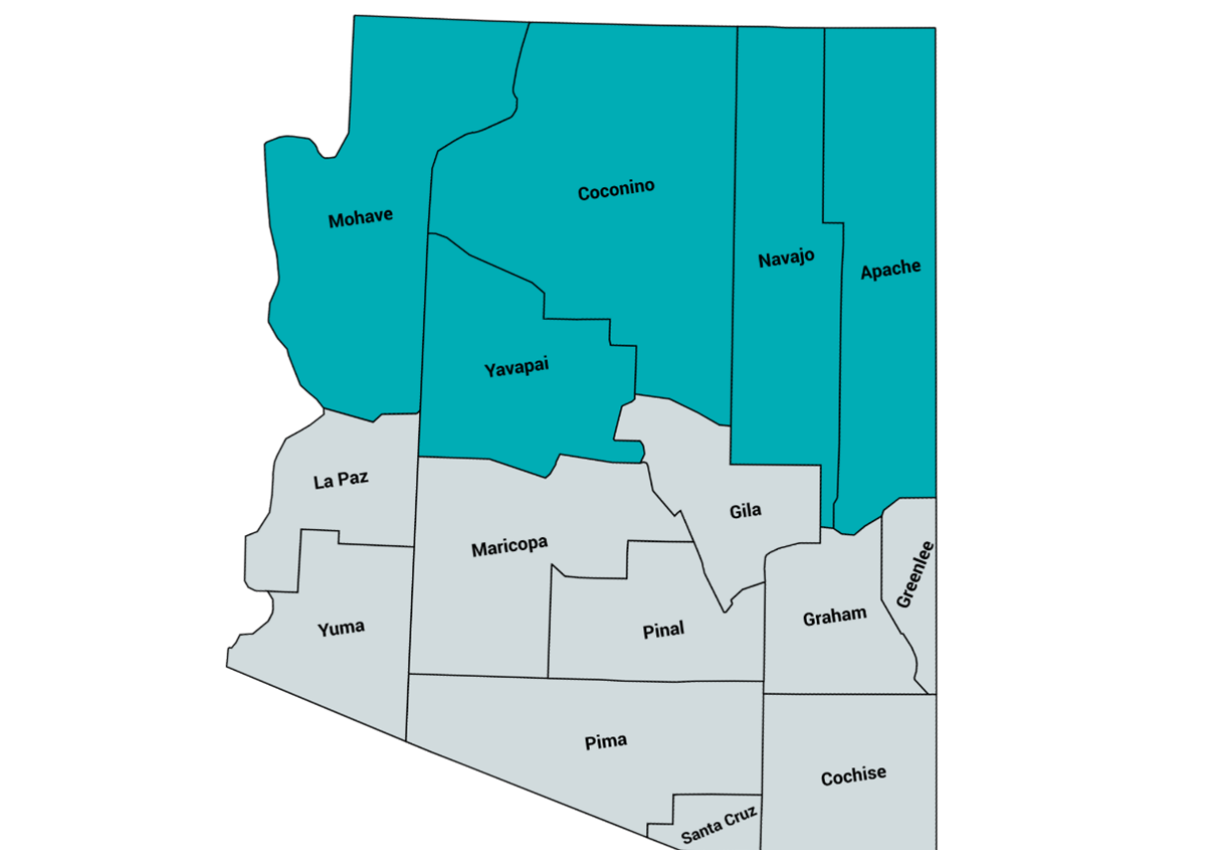
Figure 1. Map of northern Arizona